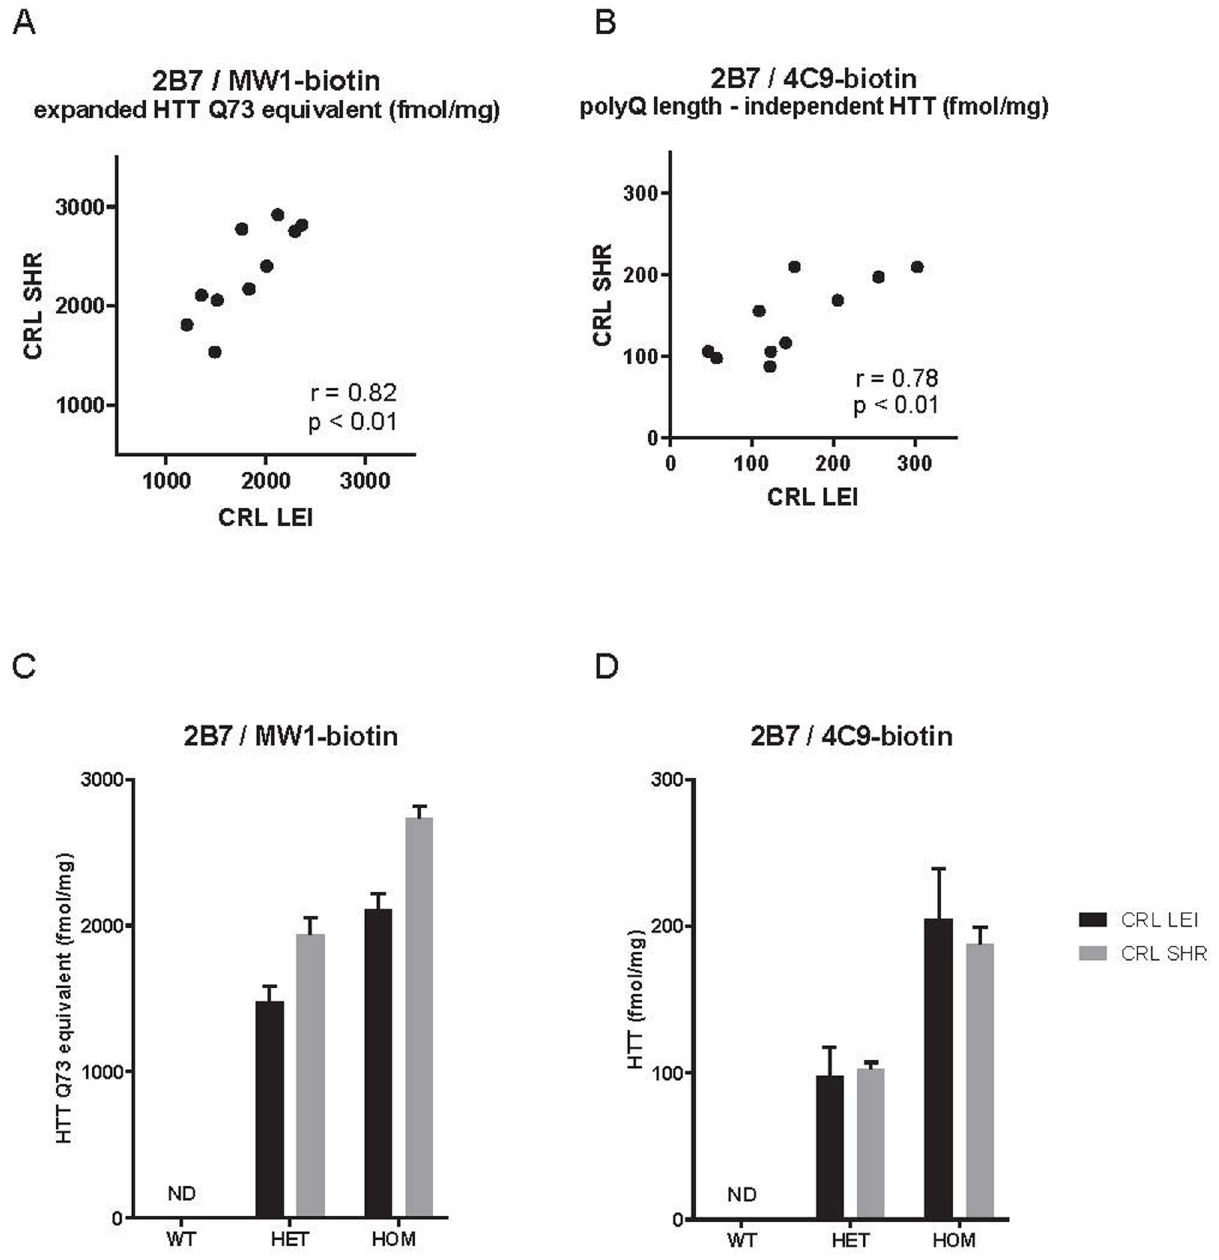
Fig 6. Correlation between HTT protein levels determined in the same lysates of heterozygous zQ175DN mouse brain lysates in two independent laboratories in the Netherlands (CRL-LEI) and in the U.S. (CRL-SHR). The zQ175DN allele product was quantitated with two different MSD assays (2B7/MW1 for polyglutamine expanded HTT (A and C) and 2B7/4C9 for total human HTT (B and